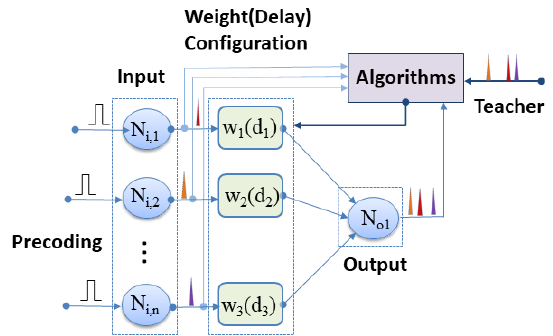
Figure 9. The SNN learning structure.